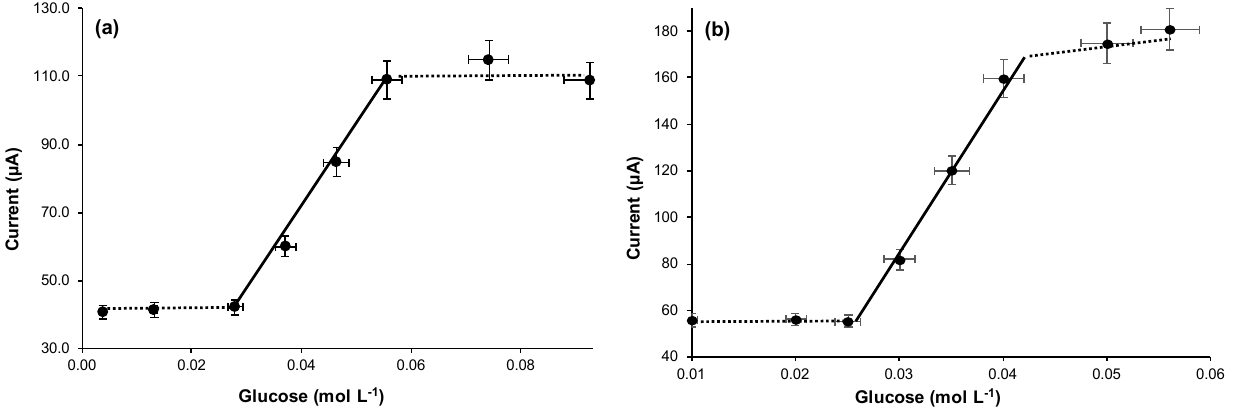
Figure 4. Behavior of current as a function of the increase in glucose concentration ( a ) operating at 25 °C; ( b ) operating at 28.5 °C, for a fixed yeast concentration (0.6 g in 30 mL of aqueous glycine solution).